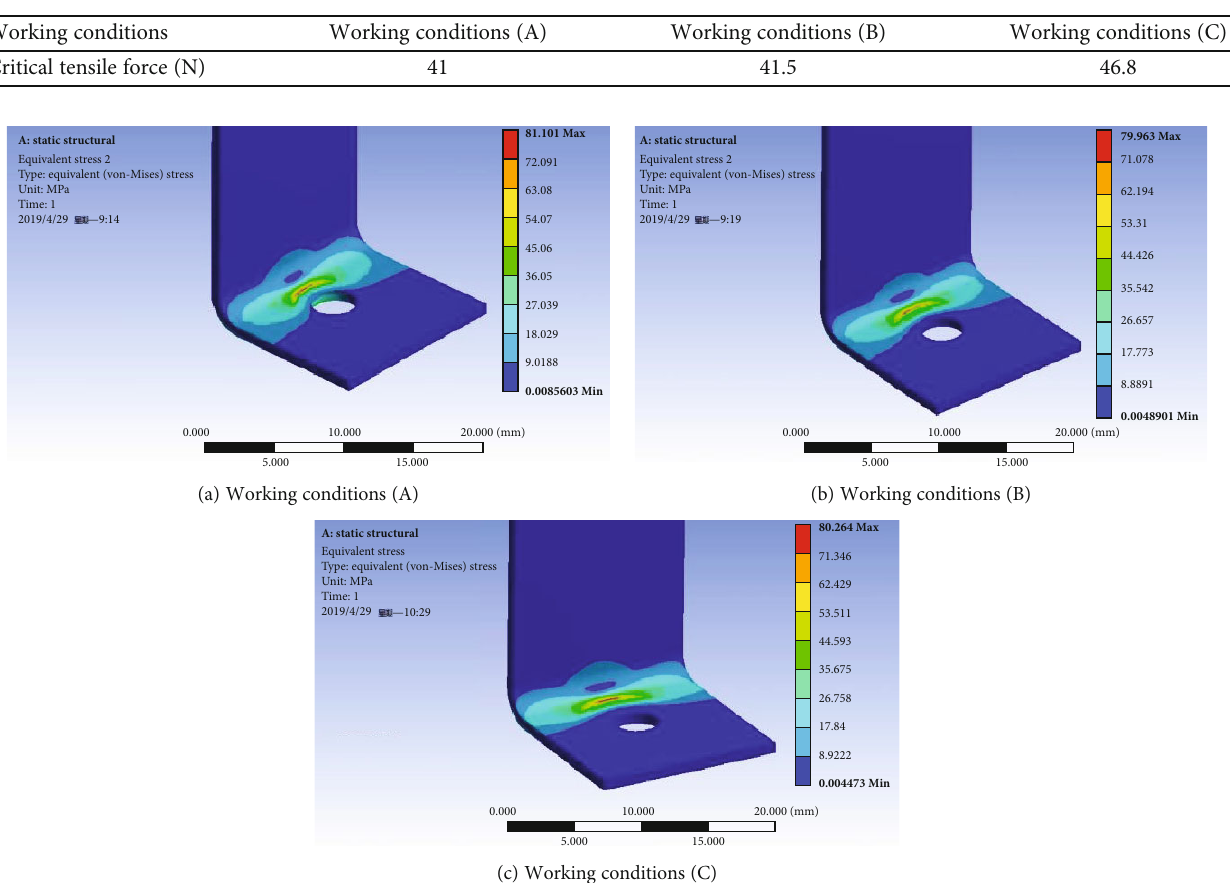
Table 6: The critical tensile force of nylon ribbon corresponding to di ff erent riveting joint diameters.